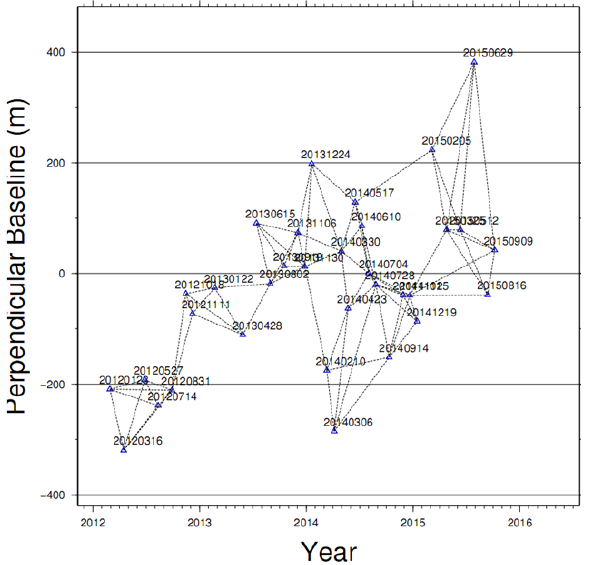
Figure 3. Spatial and temporal baselines of Radarsat-2 SAR images used in this study.